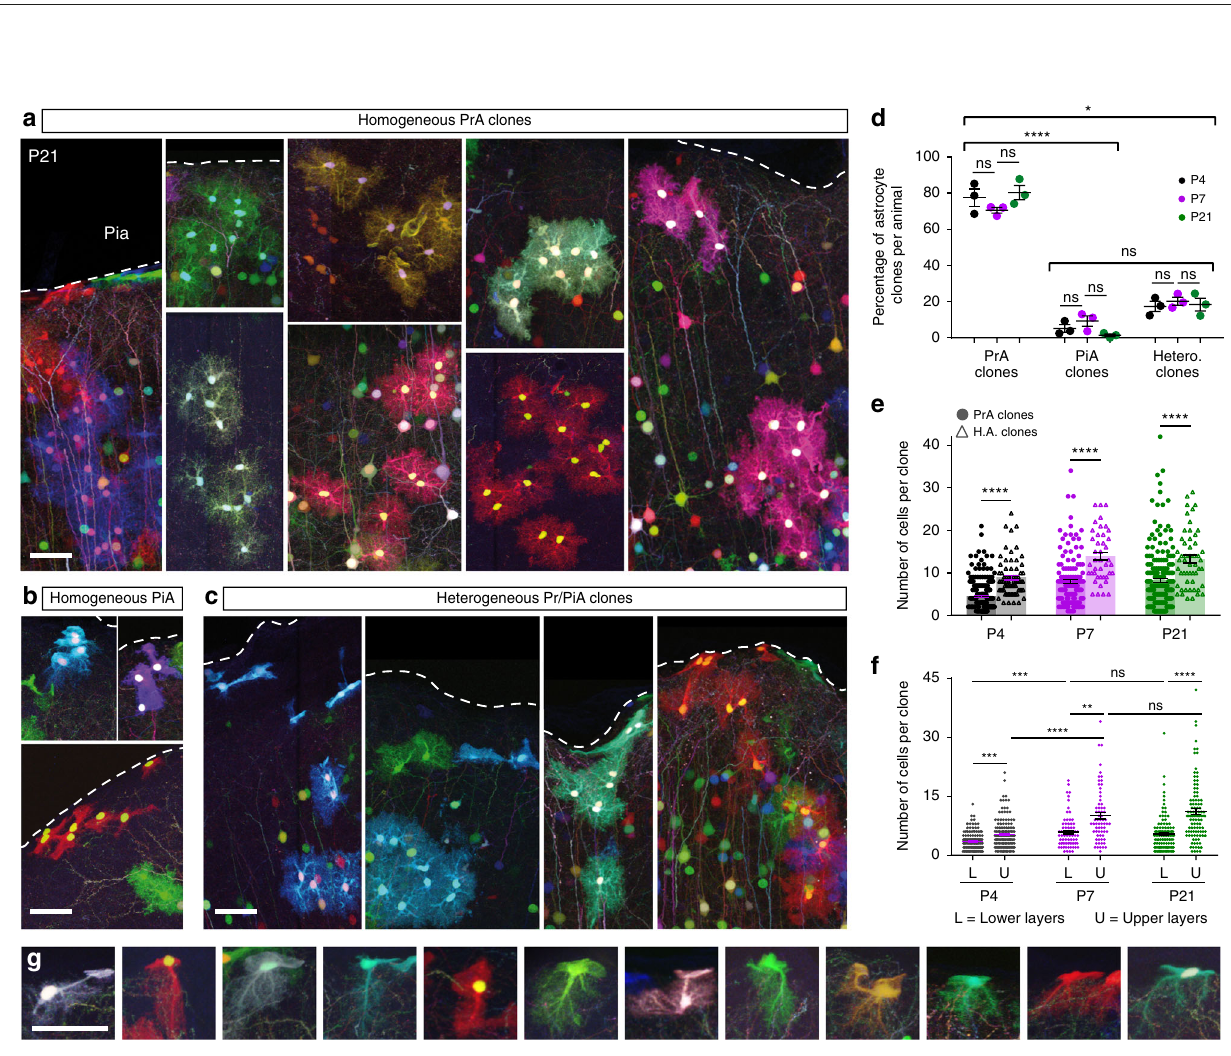
Fig. 4 Individual cortical progenitors can generate both protoplasmic and pial astrocytes. a – c Examples of homogeneous clones of PrA ( a ) or PiA ( b ) and heterogeneous clones containing both astrocyte types ( c ). d PrA, PiA, and heterogenous clones were found in stable proportions (respectively 76%, 5%, and 19% of clones) throughout postnatal development (P4 – P7 – P21), with a signi fi cant majority of homogeneous PrA. e Heterogeneous astrocyte clones comprise signi fi cantly larger number of cells than homogeneous PrA clones. f PrA clones whose barycenter is located in the upper half of the cortex (U) are larger than those in lower layers (L) at P4, P7, and P21. Clone barycenter is calculated using the mean of sister cells relative DV positions. g Examples of intermediate morphologies between PiA and PrA observed at P21, presenting both fi broblast-like features at one extremity and bushy rami fi cations at the other extremity. Graph values indicate means ± s.e.m. Kruskal – Wallis associated with Dunn ’ s multiple comparisons statistical tests have been performed. **** indicates p value < 0.0001. N = 9 animals. Scale bars: 50 µ